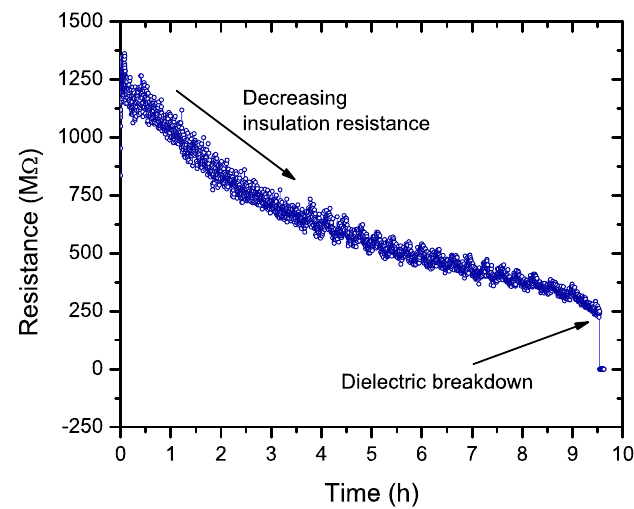
Figure 7. Insulating resistance decrease during individual sample tests under combined stress conditions (140 °C, 400 V) for MLCC-3 capacitors. The dielectric breakdown of the MLCC is detected when there is a sharp drop in the resistance value.